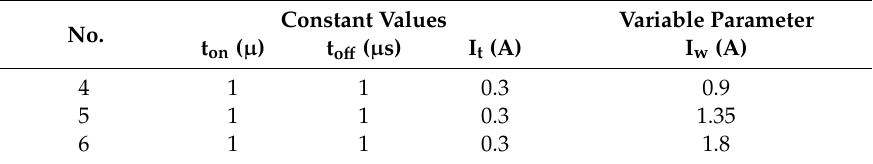
Table 3. The research plan—series